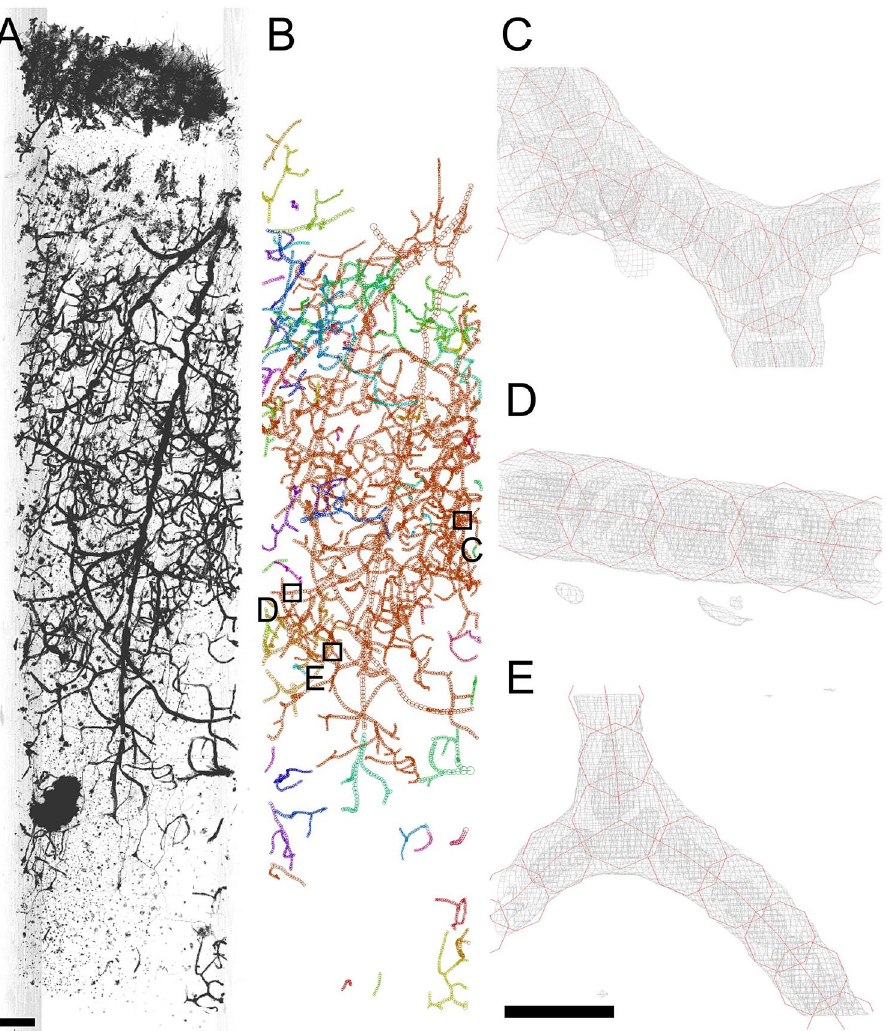
Figure 1. Rendering of three-dimensional image of BA22 cerebral tissue of schizophrenia case S1 and Cartesian-coordinate model of its vessel network. The pial surface is toward the top. ( A ) Three-dimensional image of the tissue. Linear attenuation coefficients of 8–50 cm −1 were rendered in gray scale with the maximum projection method of the VG Studio software. Scale bar: 100 μm. ( B ) Cartesian-coordinate model of vessel network built by tracing the three-dimensional image. The model is viewed from nearly the same direction as the rendering. The vessel models of the other 23 samples were built in the same manner (Supplementary Figures S1–S17). The model was drawn with the MCTrace software. Model constituents are color-coded. The vessels magnified in panels C – E are indicated with boxes. ( C – E ) Cartesian-coordinate models of capillary vessels (red) superposed on cage representations of the three-dimensional image (gray) contoured at 6 times the standard deviation of the image from its mean intensity. Blood cells were visualized in the vessel lumen as low- intensity bodies. Positions of these vessels are indicated with boxes in ( B ). Scale bar: 10